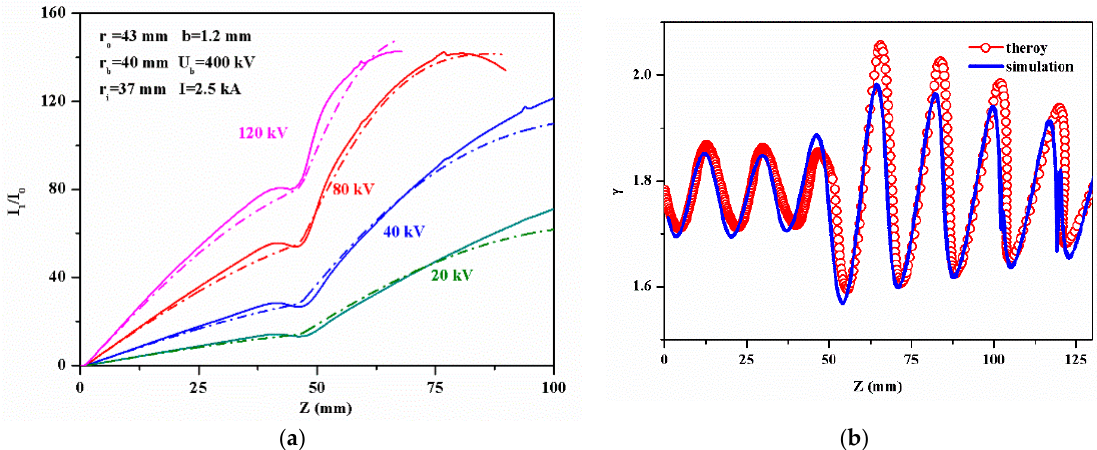
Figure 5. ( a ) The first harmonic current versus different modulation voltage: full lines show theoretical results while dotted lines show simulation results. ( b ) The velocity dispersion versus displacement Z.